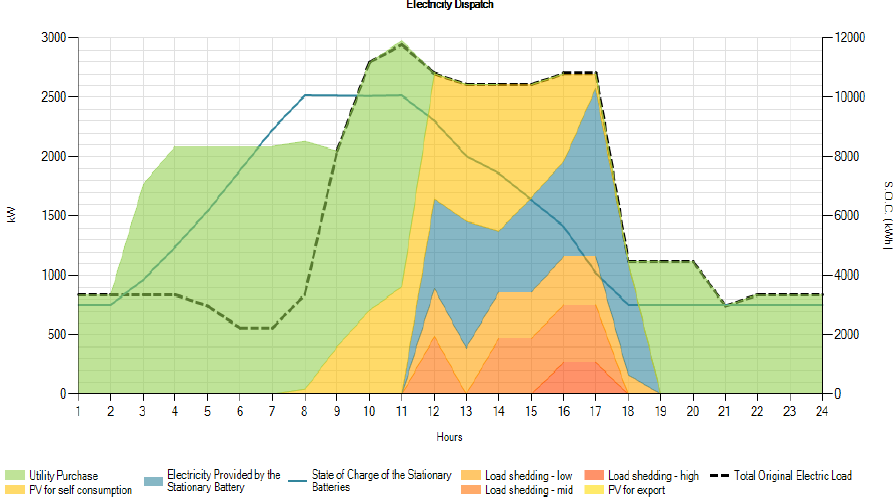
Figure 10. VPP autonomous operation with DER & storage.